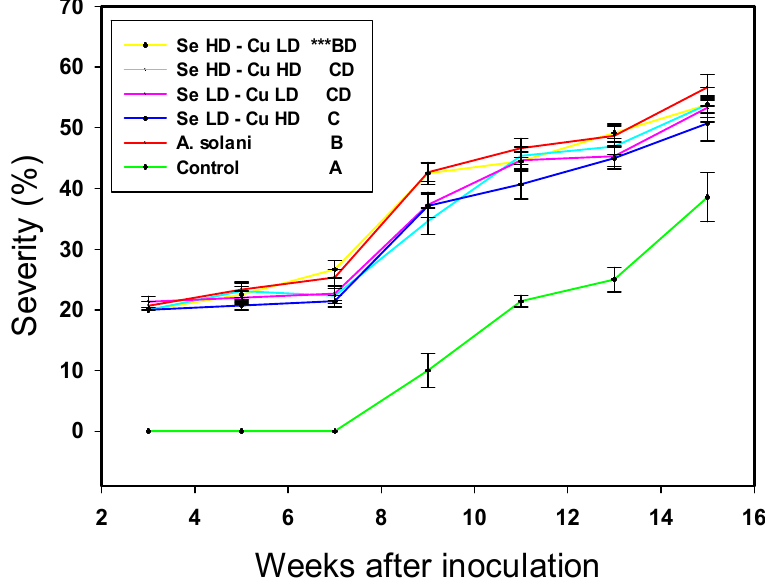
Figure 1. Severity of A. solani in tomato plants throughout crop development. Control: no inoculation of A. solani or application of NPs. A. solani: Control inoculated with A. solani without application of NPs. Se LD-Cu LD: 10 mg L − 1 of Se NPs + 10 mg L − 1 of Cu NPs. Se LD-Cu HD: 10 mg L − 1 of Se NPs + 50 mg L − 1 of Cu NPs. Se HD-Cu LD: 20 mg L − 1 of Se NPs + 10 mg L − 1 of Cu NPs. Se HD-Cu HD: 20 mg L − 1 of Se NPs + 50 mg L − 1 of Cu NPs. Bars represents the standard error of the mean.